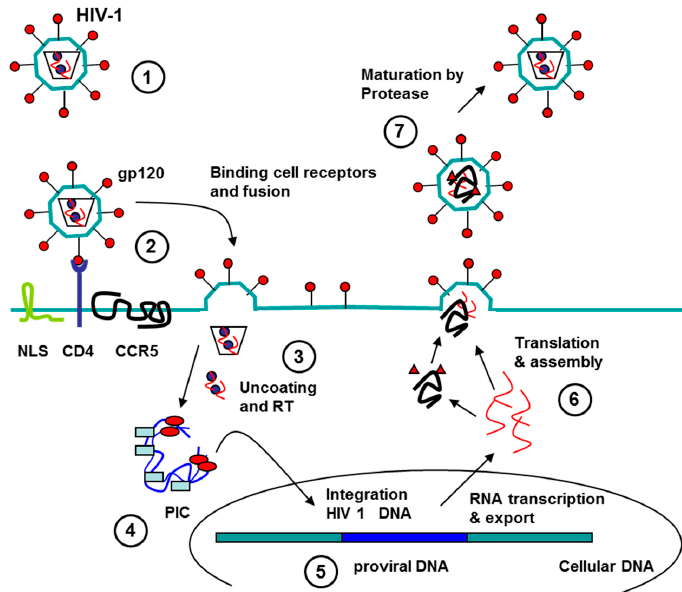
Figure 2. Scheme showing the targets for aptamers in HIV-1. ( 1 ) The HIV viral particle has an inner capside containing ssRNA viral genome and integrase and retro-transcriptase proteins, mainly; ( 2 ) The outer envelope has gp120 and gp40 proteins involved in interaction with cellular receptors (CD4, CCR5, NLS) and fusion to cellular membrane; ( 3 ) In the cytoplasm the ssRNA viral genome is released and the retro-transcription step is produced; ( 4 ) The integrase protein binds to dsDNA viral genome by LTR ends sequences and other cellular proteins forming the pre-integration complex (PIC); ( 5 ) The PIC goes into nucleus through the nuclear pore and is integrated in the cellular genome by the integrase protein activity (provirus); ( 6 ) The viral RNAs are transcripted from proviral DNA and exported to cytoplasm to translate viral proteins as protease and a big pre-protein that are assembled to new RNA viral genomes and leave the cell with outer envelope from the cellular membrane; ( 7 ) After the budding viral particle, the proteases process the big pre-protein and get a mature viral particle.